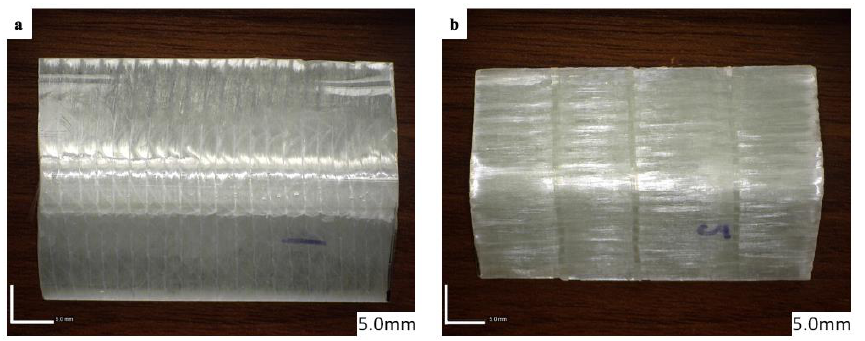
Figure 2. ( a ) Axial and ( b ) lateral fiber orientation.